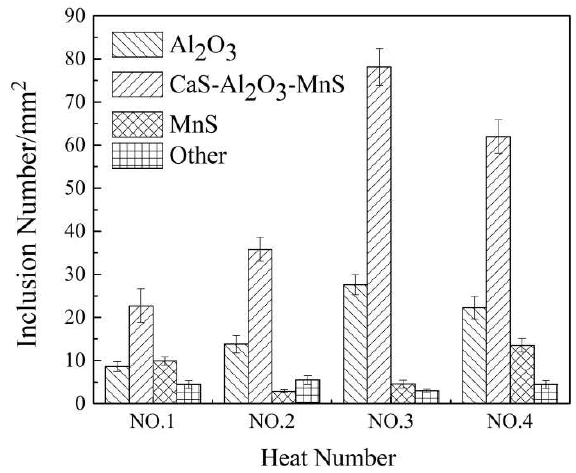
Figure 6. The number of different types of inclusions in billets.